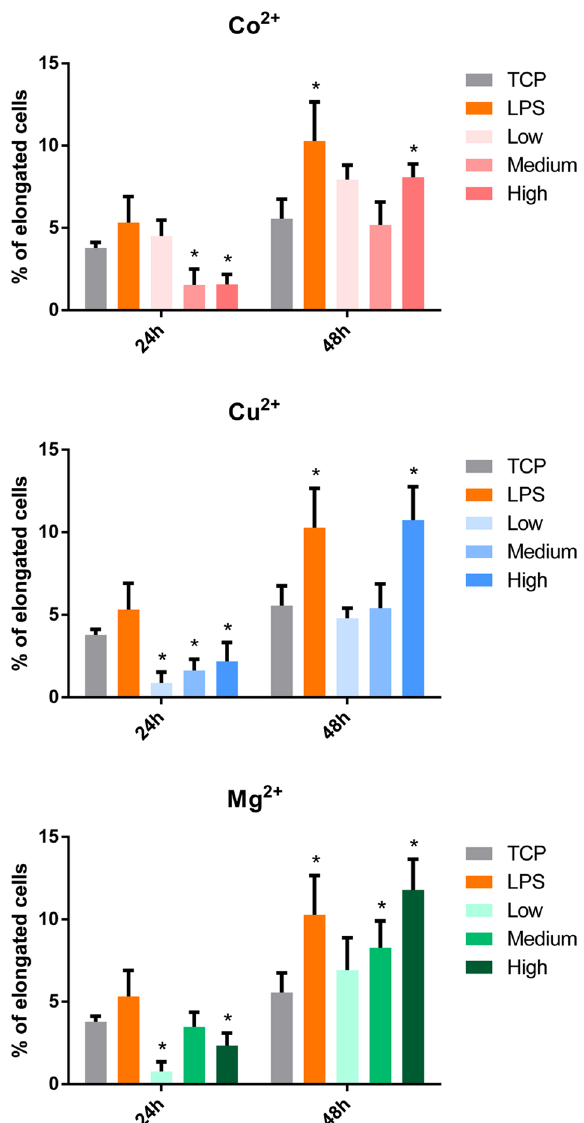
Figure 5. Quantitative analysis of THP-1 cell morphology. The number of elongated cells (aspect ratio higher than 2.5) in each condition was represented. Statistical significance was accepted at p < 0.05 and represented with *. The correlation analysis between cell elongation and gene expression can be found in Supplementary Table